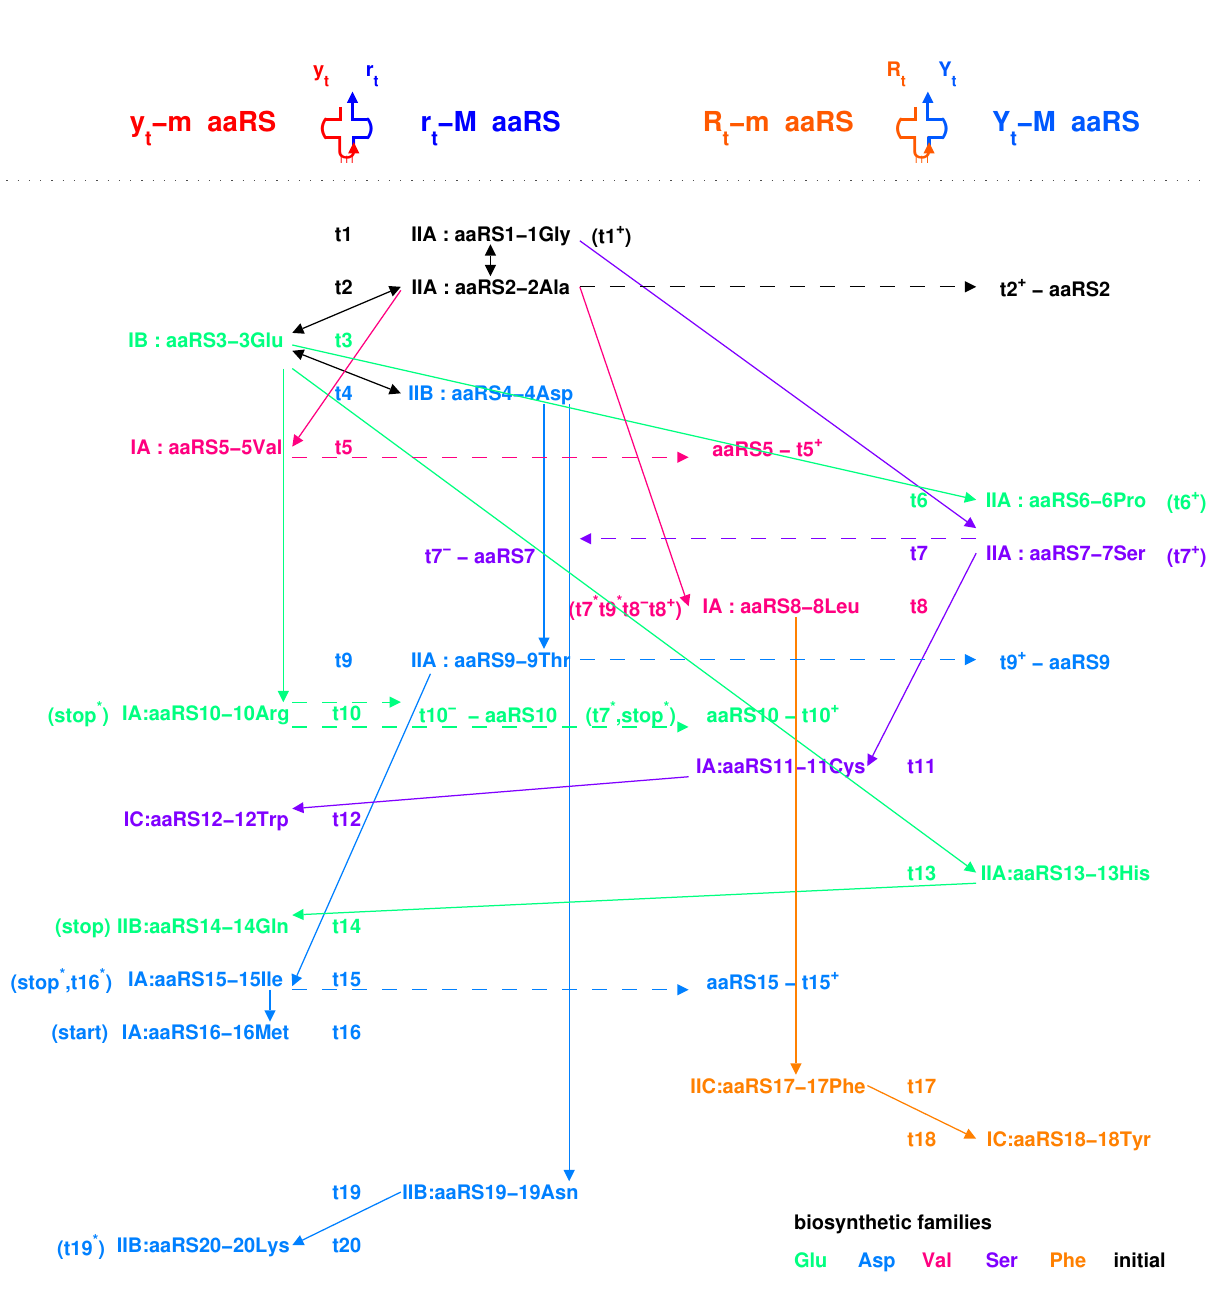
Figure 7. The coevolution of tRNAs with aaRSs. The coevolution of the four classes of aaRSs and the corresponding two types of tRNAs in accordance with the biosynthetic families indicated in certain colours. The ancestor of aaRS, namely aaRS 1, corresponding to the non-chiral amino acid 1 Gly , belongs to the r t − M class. The codon degeneracy are due to the coevolution of tRNAs with aaRSs, where the surplus tRNAs were chosen by the rare aaRSs. There are some truths in the traditional classifications of aaRSs, but the evolutionary relationships of aaRSs are so intricate, as shown here. The start and stop codons generally appear in the positions corresponding to y t − m class. The non-standard codons also evolved as alternative choices of tRNAs by